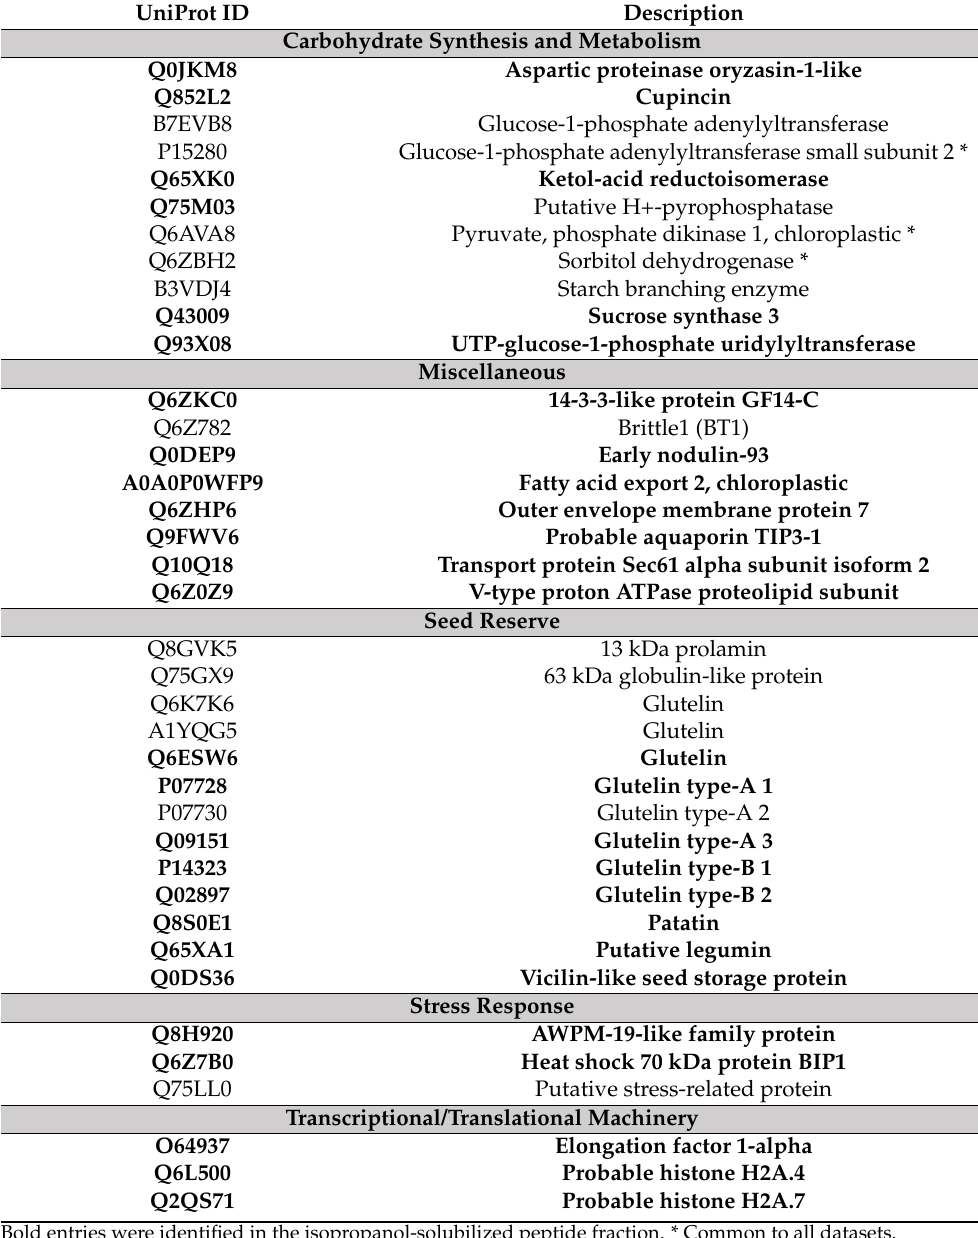
Table 2. Common proteins in the distal proteome and proximal